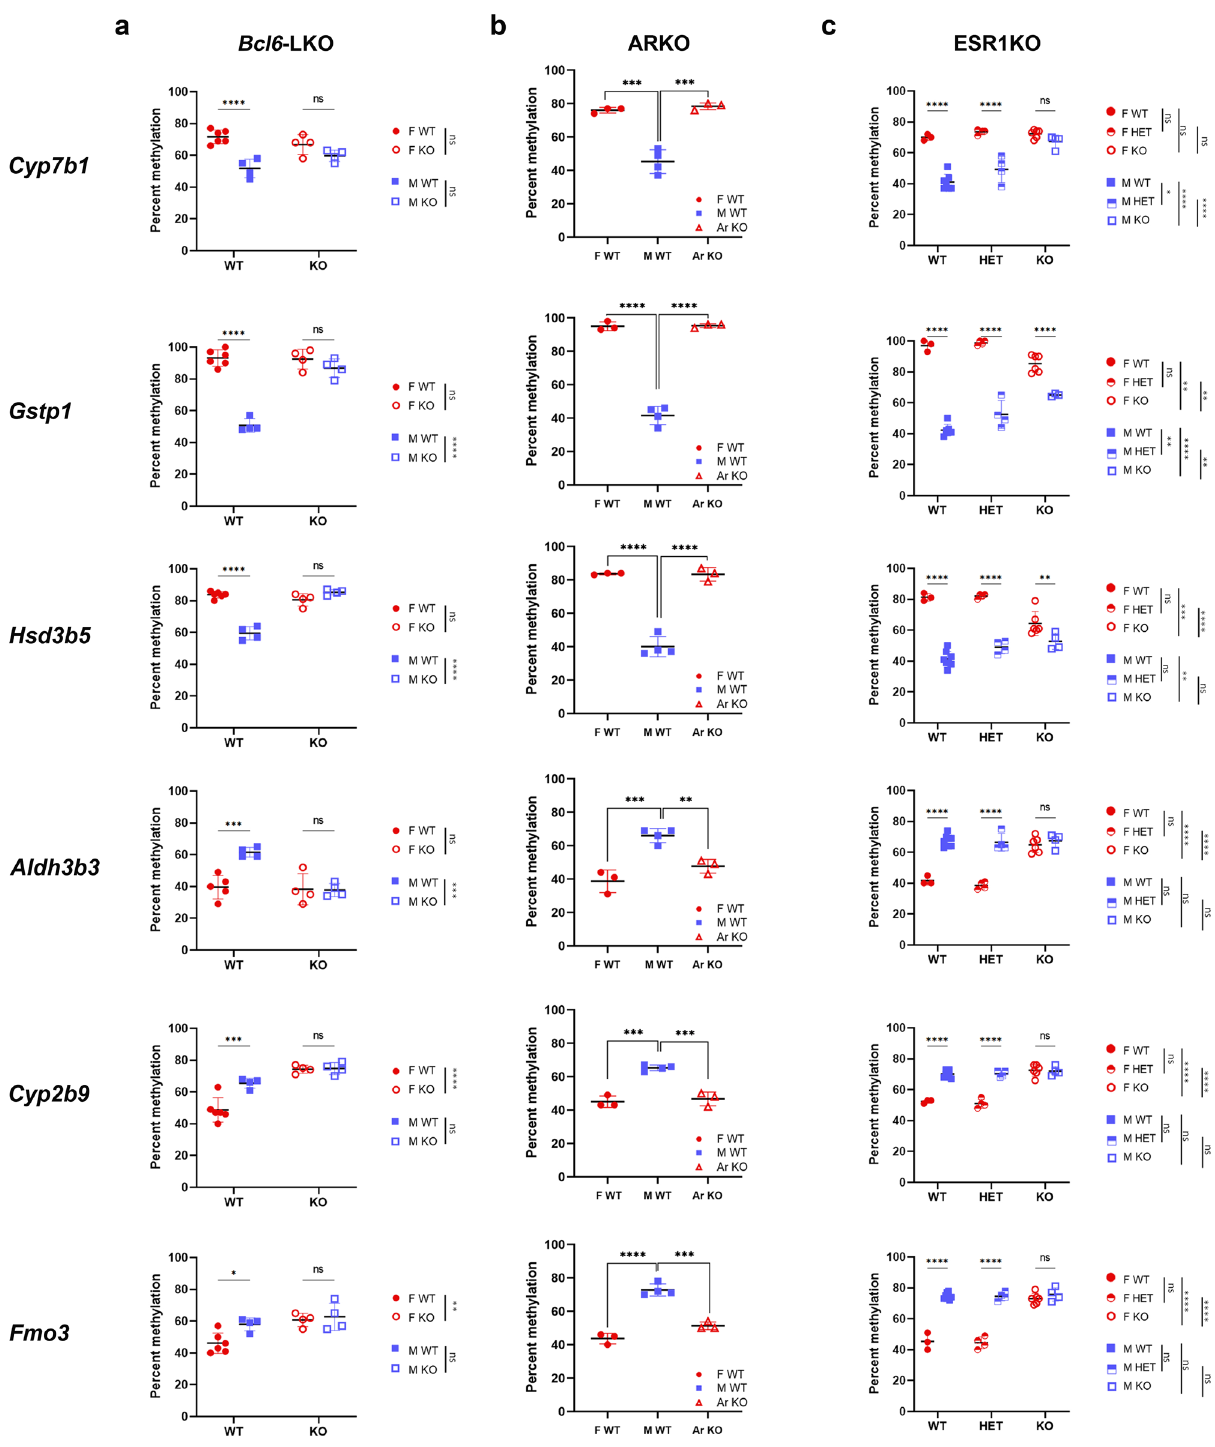
Figure 5. BCL6, AR, and ESR1 influence DNA methylation at sDMRs. ( a ) Methylation levels in male and female Bcl6 -LKO (4 females, 4 males) and controls Bcl6 -flox mice (6 females, 4 males); ( b ) Methylation levels in ARKO mice (with genetic and gonadal male sex and genital female sex) and control male and female littermates (3 females, 4 males, and 3 ARKO mice); ( c ) Methylation levels in wild type controls, heterozygous and homozygous ESR1KO mice (WT: 3 females, 7 males; HET: 4 females, 4 males, KO: 6 females, 4 males). Error bars show standard deviation. Statistically significant differences are shown with asterisks * P < 0.05, ** P < 0.01, *** P < 0.001, **** P < 0.0001, ns: non-significant [two-way ANOVA, followed by multiple testing with Sidak’s correction ( a and c ); one-way ANOVA, followed by multiple testing with Tuckey’s correction ( b